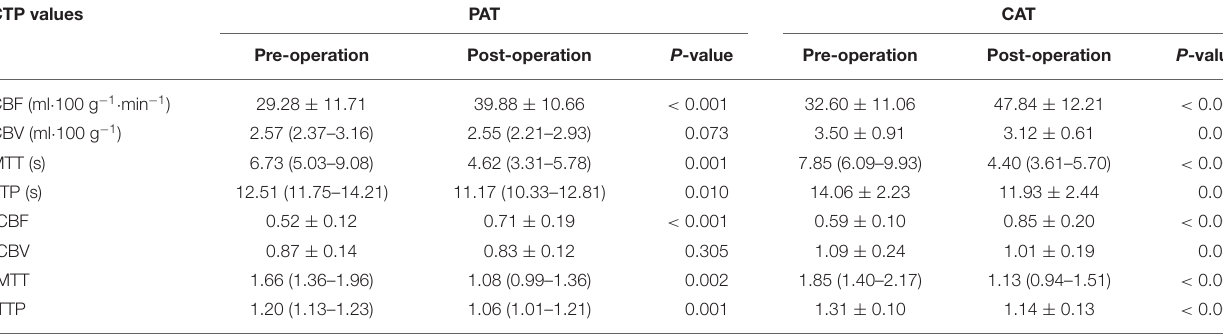
TABLE 2 | Comparison of pre- and post-operative CTP values in the regions of PAT and CAT. CTP values